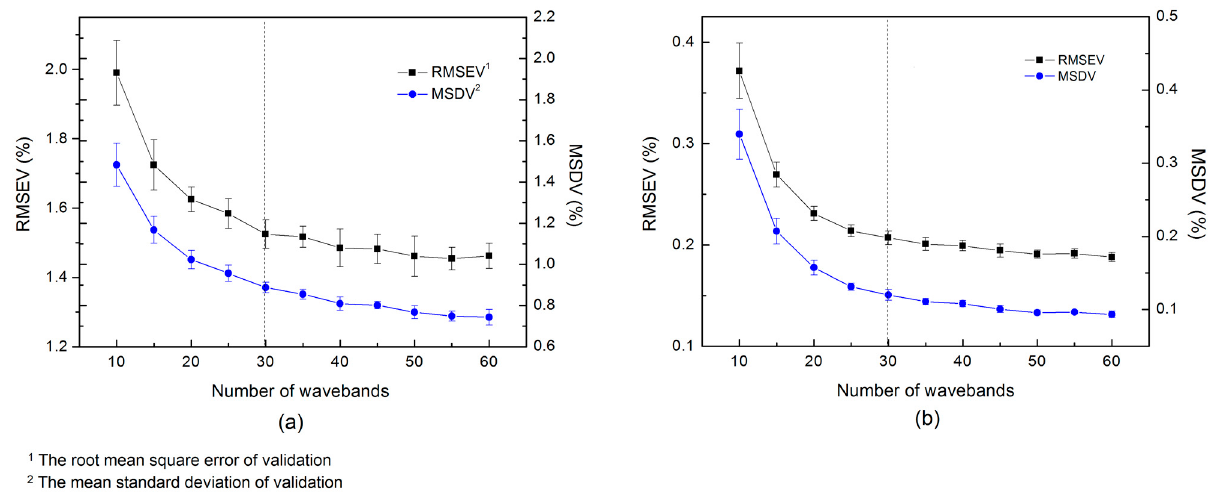
Figure 6. Optimization of the number of wavelengths (n w ) for the infant formula adulteration data sets: ( a ) hydrolyzed leather protein (HLP) data set; ( b ) melamine data set.